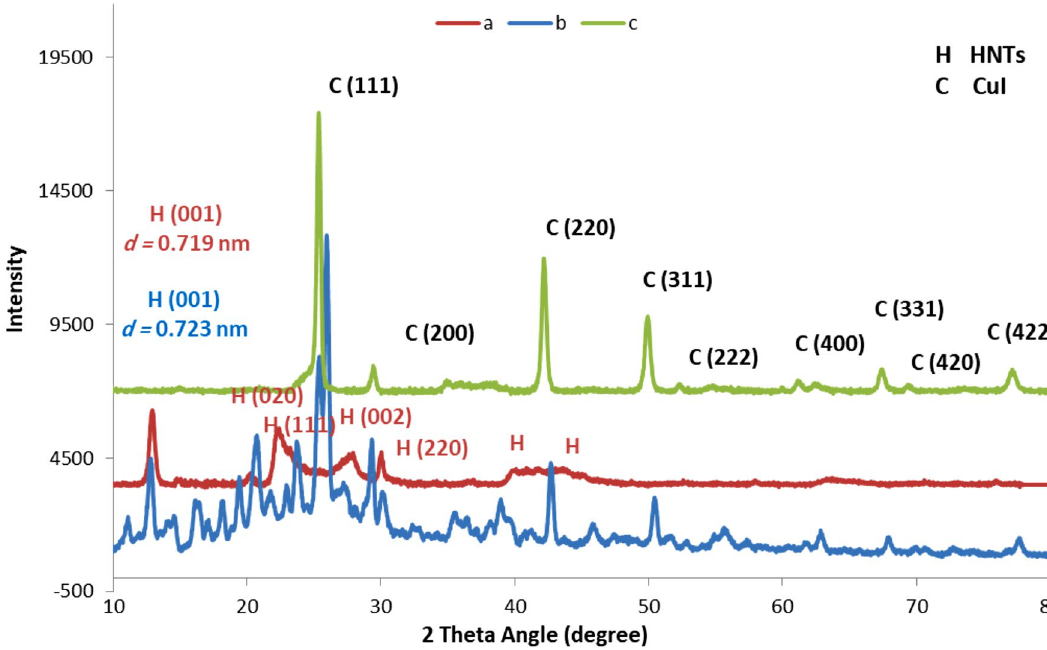
Figure 4. XRD patterns of (a) CuI@HNT-TSC-PC, (b) pure HNTs and (c) pure CuI.